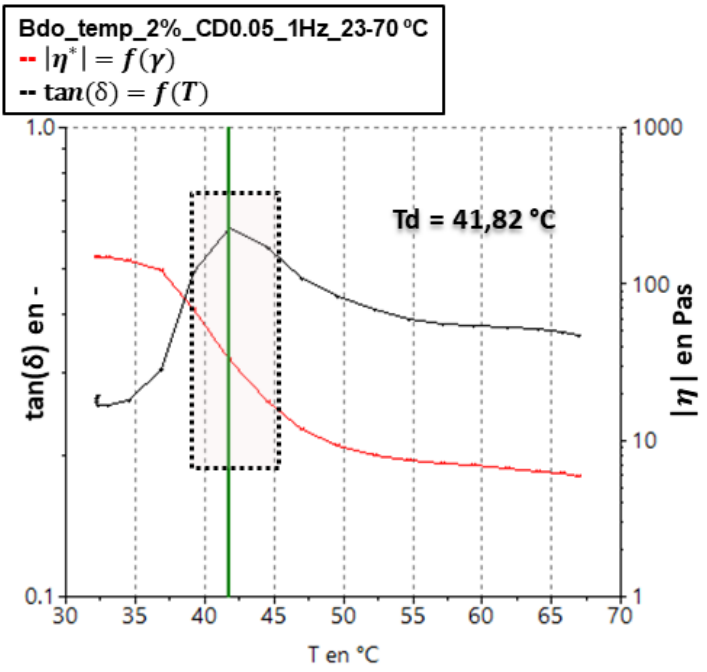
Figure 2. Determination of the denaturation temperature of the collagen mass at 2% wt. Once the denaturation temperature (maximum test temperature) and the linear vis- coelastic region were obtained, frequency sweeps were performed at different temperatures (between 23 ◦ C and 40 ◦ C, depending on the sample) to obtain the values of the dynamic moduli that were needed for the calculation. At this stage, it was important to define the crossover frequency G (cid:48) = G (cid:48)(cid:48) (related to elastic and viscous behavior, respectively), as this point denoted the end of flow behavior, which was dominated mainly by molecular weight, and the beginning of rubbery behavior, where the effect of molecular entanglements predominated. It was also important to corroborate that with increasing test temperature the crossover where G (cid:48)(cid:48) = G (cid:48) was at higher frequencies, because the increased temperature enabled the material molecules to be more mobile and to relax in less time. Table 2. Value of the denaturation temperatures measured for each concentration of the studied collagen